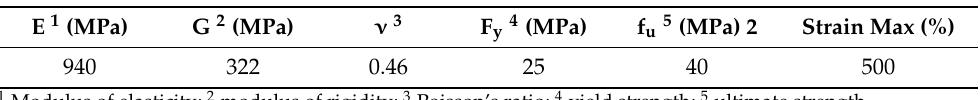
Table 2. Mechanical properties for UHMWPE liner